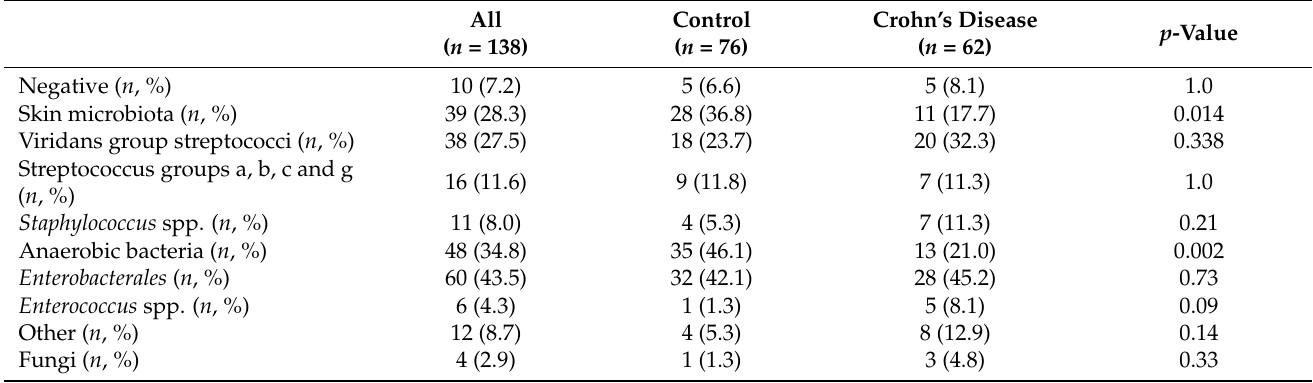
Table 2. Microbial spectrum of perianal abscess formations of patients with Crohn’s Disease and without.